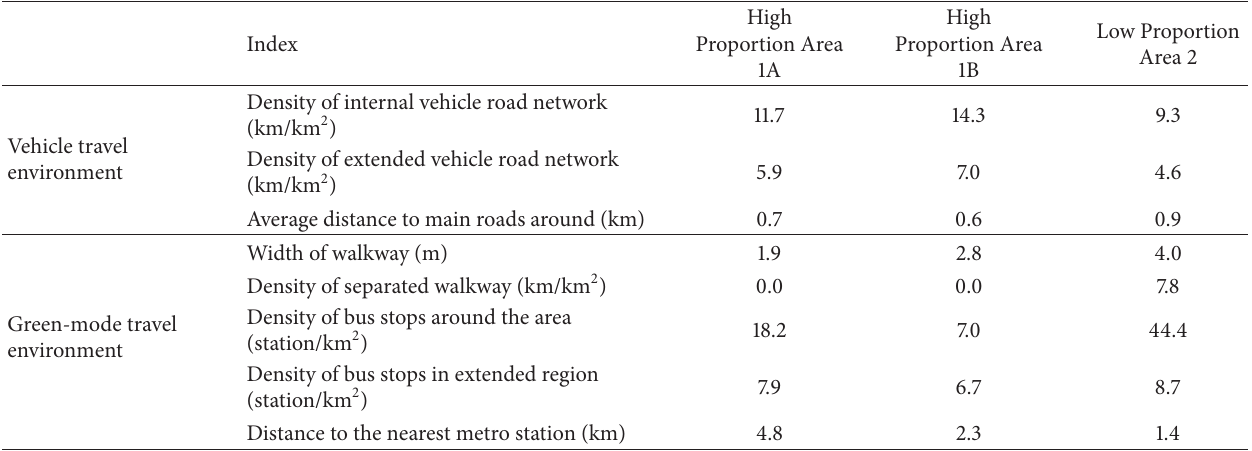
Table 1: Comparison of travel environment in each area.